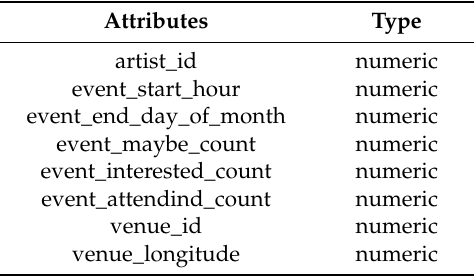
Table 2. Classes, properties and facets of LODSE ontology.